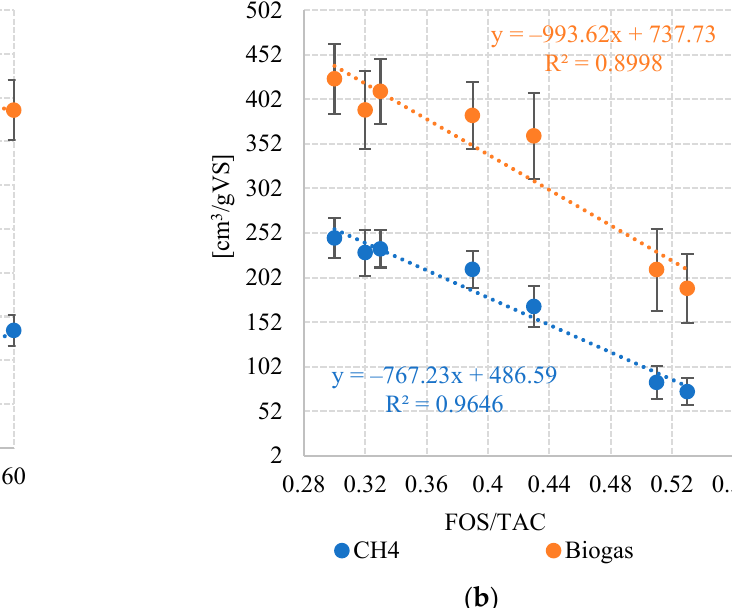
Figure 4. Correlations between ( a ) CTS in the feedstock and VFA/total alkalinity, ( b ) FOS/TAC and specific biogas/CH 4 production.